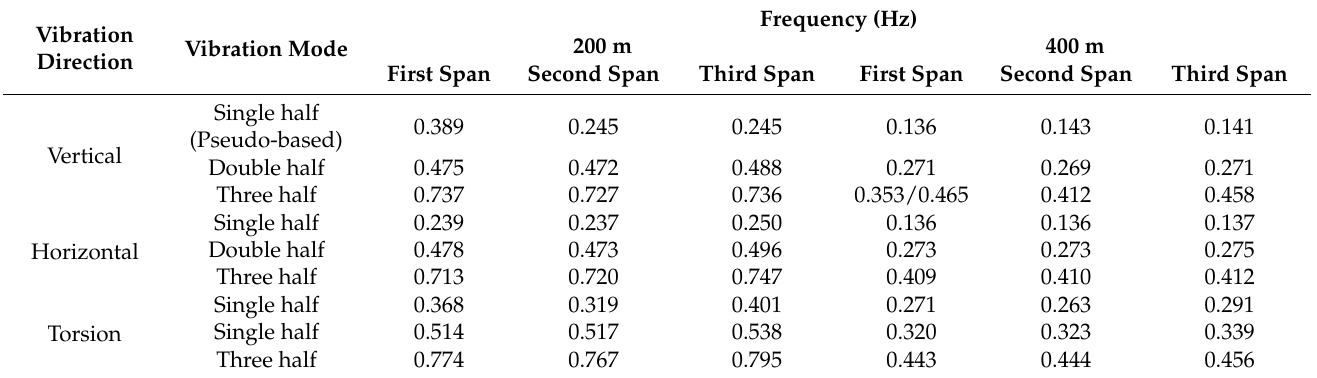
Table 2. Low-order mode of three spans iced eight-bundle